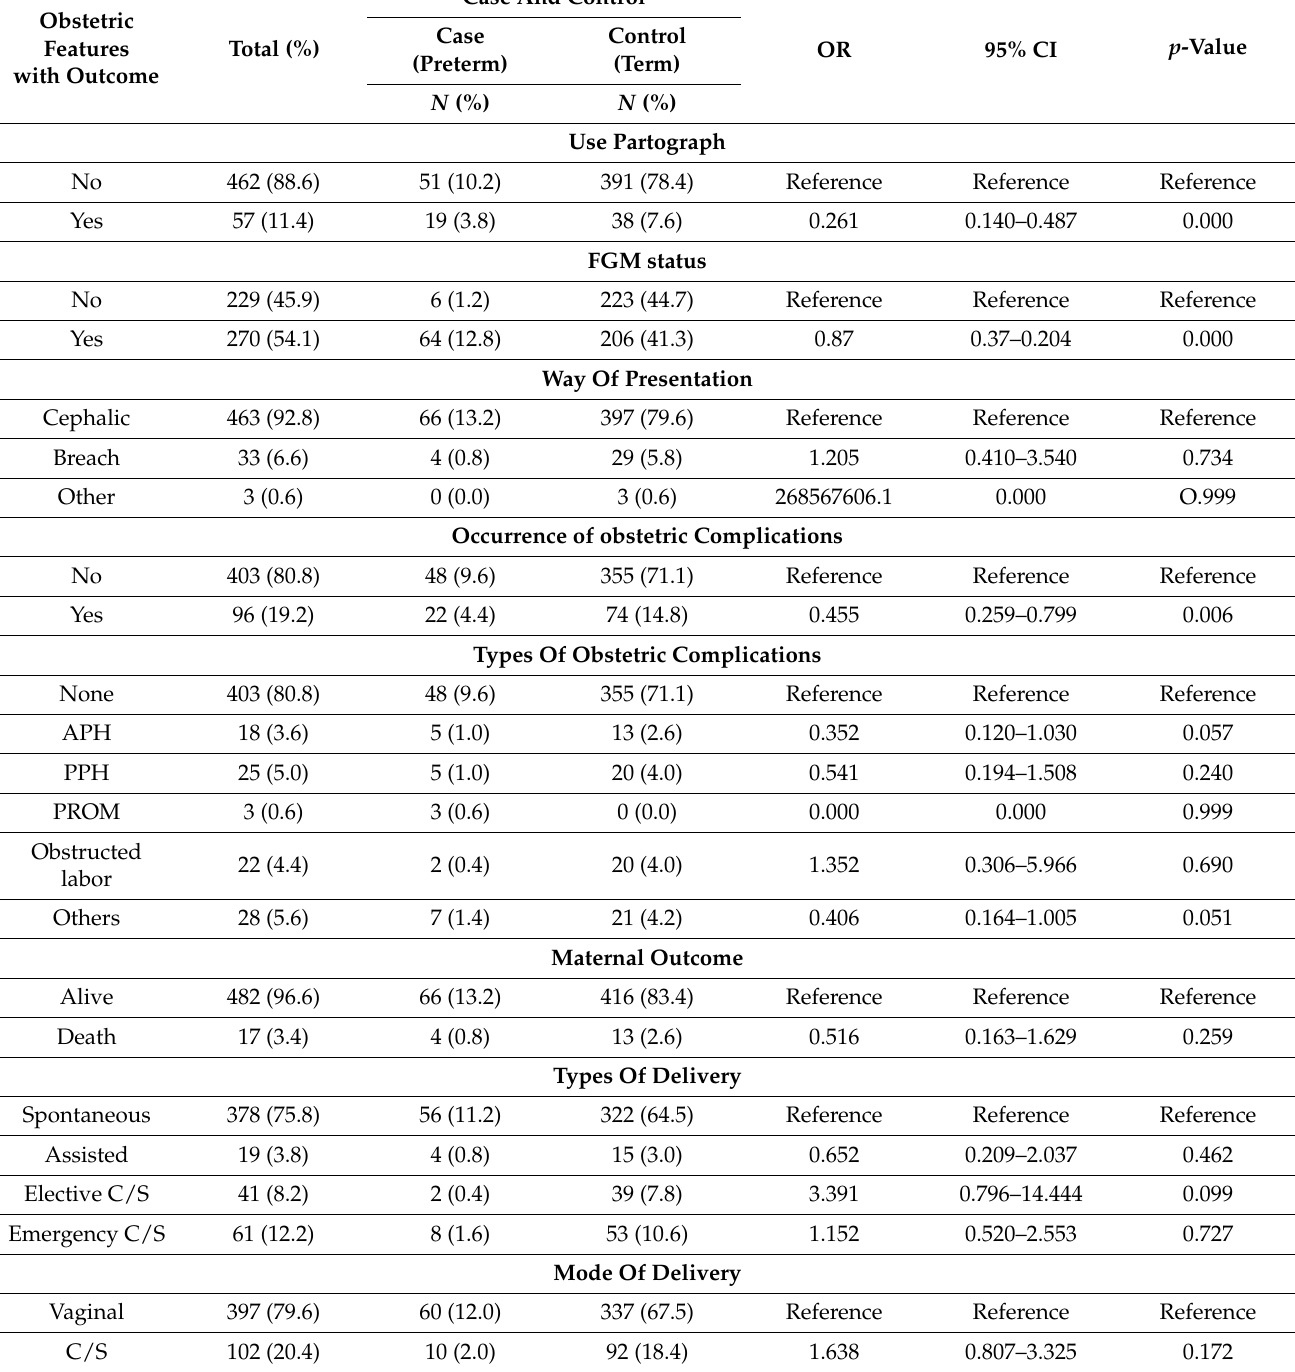
Table 4. Maternal obstetric factors and preterm birth among pregnant women delivered in the four hospitals, Mogadishu,